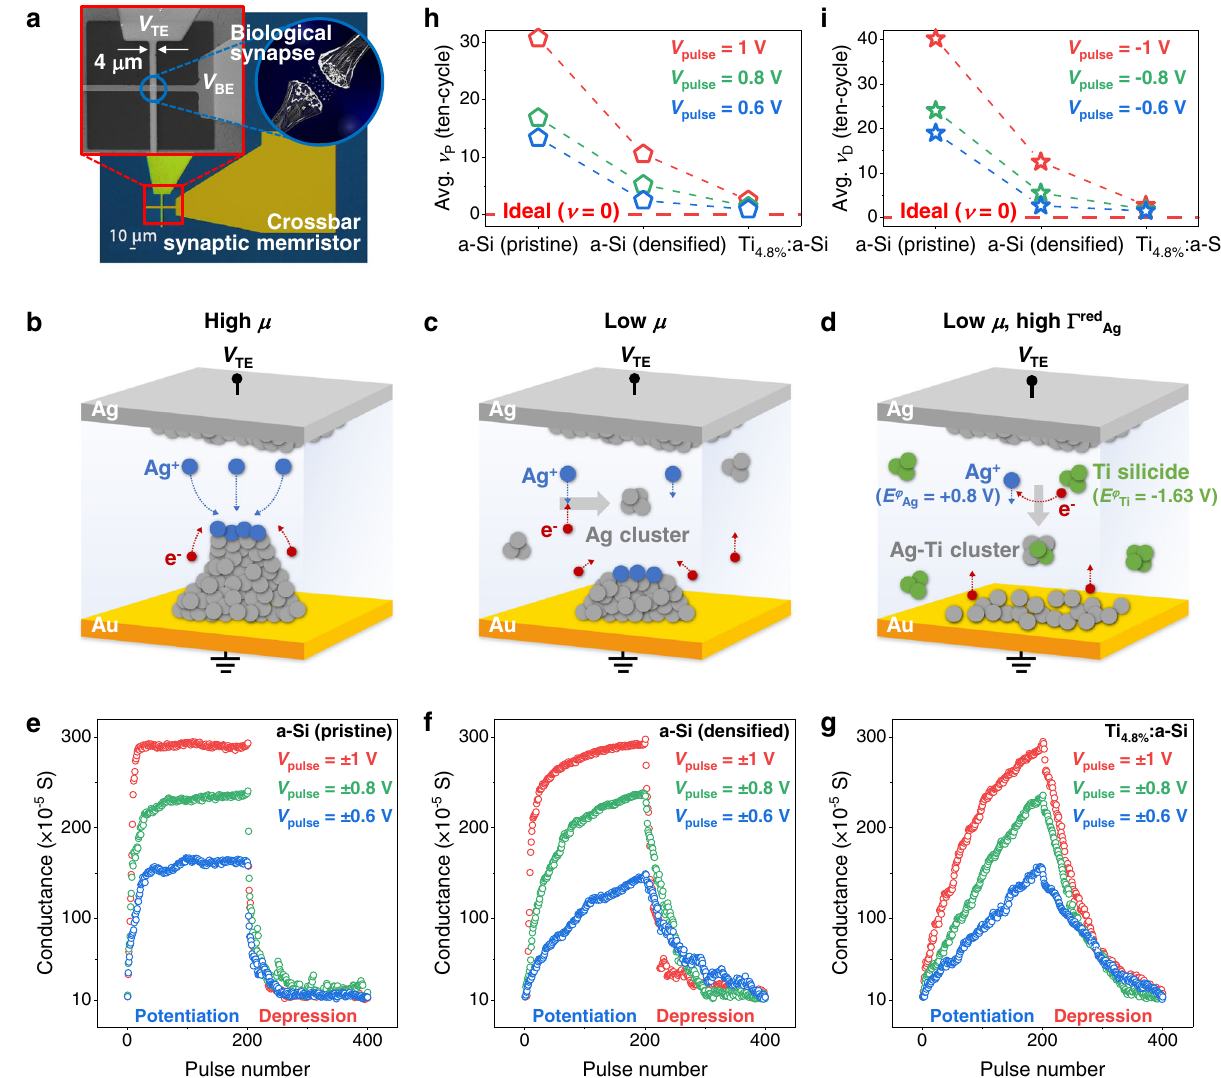
Fig. 1 The effect of cluster-type switching dynamics in analogue linearity. a Microscopic image of an a-Si synaptic memristor (left inset: scanning electron microscopy (SEM) image of crossbar structure, right inset: illustrated biological synapse). Device schematics with operation mechanism illustration for each memristor situation, b high cation mobility ( μ ) case for a-Si (pristine) device, c low μ case for a-Si (densi fi ed) device, and d low μ and high Ag reduction probability ( Γ red Ag ) case for Ti 4.8% :a-Si device. Grey, blue, green, and red spheres represent Ag atoms, Ag ions, Ti atoms, and electrons, respectively. E φ Ag and E φ Ti represent standard reduction potentials of Ag and Ti. Analogue conductance updates under three different pulse conditions (blue: 0.6/ − 0.6 V, green: 0.8/ − 0.8 V, red: 1/ − 1 V with 1 μ s duration for potentiation/depression) in e a-Si (pristine), f a-Si (densi fi ed), g Ti 4.8% :a-Si devices. The conductance was measured with a read pulse (0.1 V, 1 μ s) after each programming pulse. h Average potentiation and i depression nonlinearity factors of a-Si (pristine), a-Si (densi fi ed), and Ti 4.8% :a-Si memristors for ten-cycle at each pulse